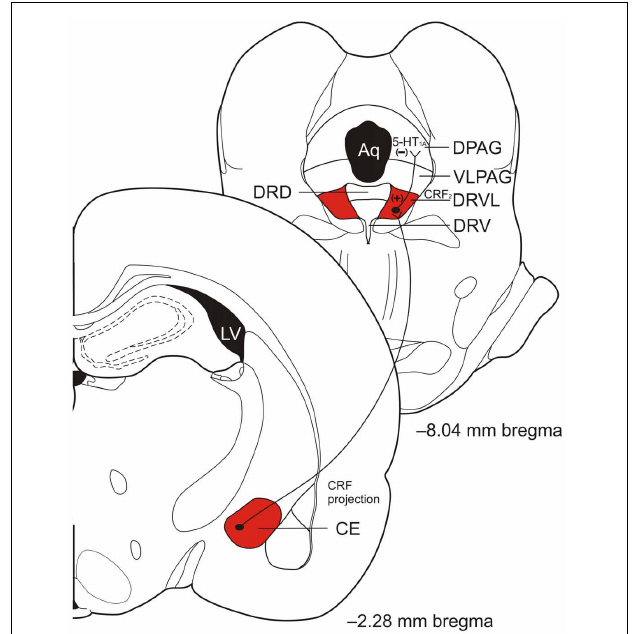
FIGURE 2 | Diagram of proposed central nucleus of the amygdala (CE) corticotropin-releasing factor (CRF) projections to the ventrolateral part of the dorsal raphe nucleus (DRVL) and DRVL serotonergic projections to the dorsal periaqueductal gray (DPAG) involved in panic inhibition during fear expression, such as freezing behavior. Excitatory projections from the CE excite serotonergic neurons in the DRVL that in turn release serotonin (5-hydroxytryptamine; 5-HT) in the DPAG to act on inhibitory 5-HT 1A receptors to inhibit panic. Abbreviations: Aq, aqueduct; CE, central nucleus of the amygdala; CRF, corticotropin- releasing factor; DPAG, dorsal periaqueductal gray; DRD, dorsal part of the dorsal raphe nucleus; DRV, ventral part of the dorsal raphe nucleus; DRVL, ventrolateral part of the dorsal raphe nucleus; LV, lateral ventricle; VLPAG, ventrolateral periaqueductal gray; ( + ), excitation; ( − ), inhibition. Coronal section templates reproduced from Paxinos and Watson (1998), The Rat Brain in Stereotaxic Coordinates, 4th Edition. San Diego: Academic Press: 1998 with permission from